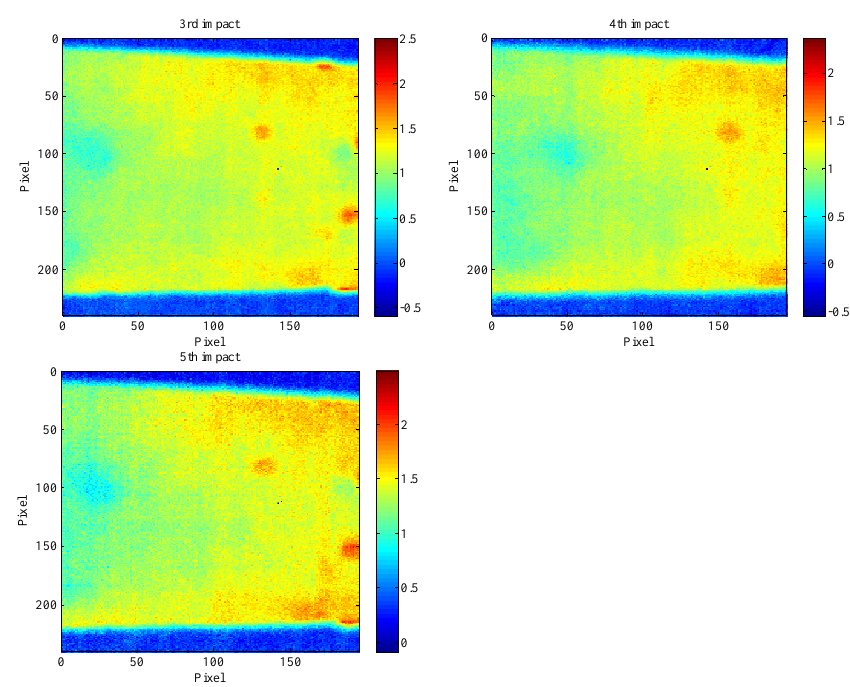
Figure 6. Thermal contrast of first five impacts in the cool ‐ down period.